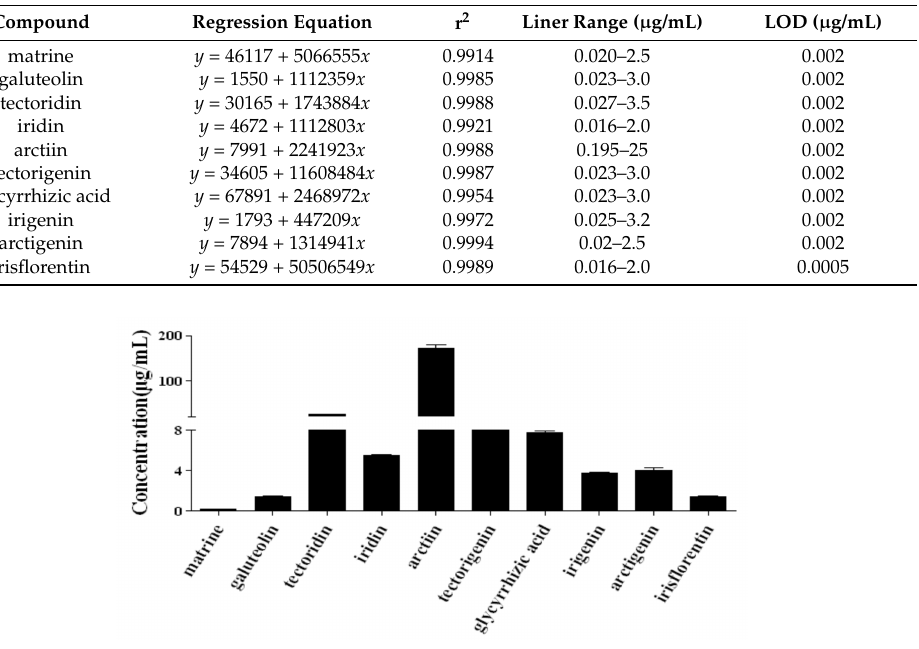
Figure 3. Content determination results of the ten compounds in Shejin-liyan